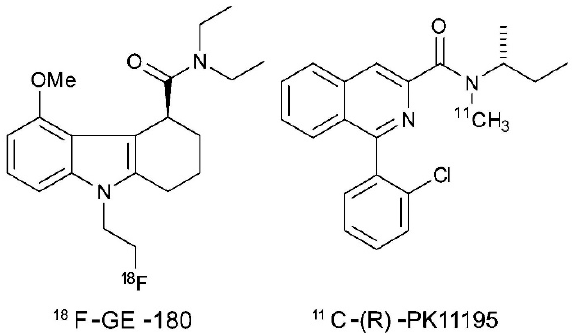
18 F-GE180 and 11 C-( R